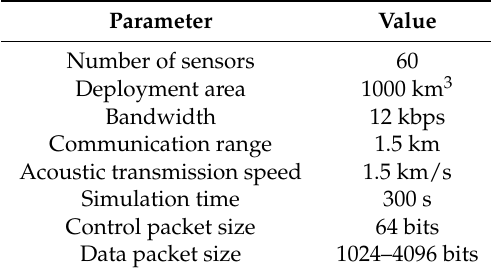
Table 2. Simulation